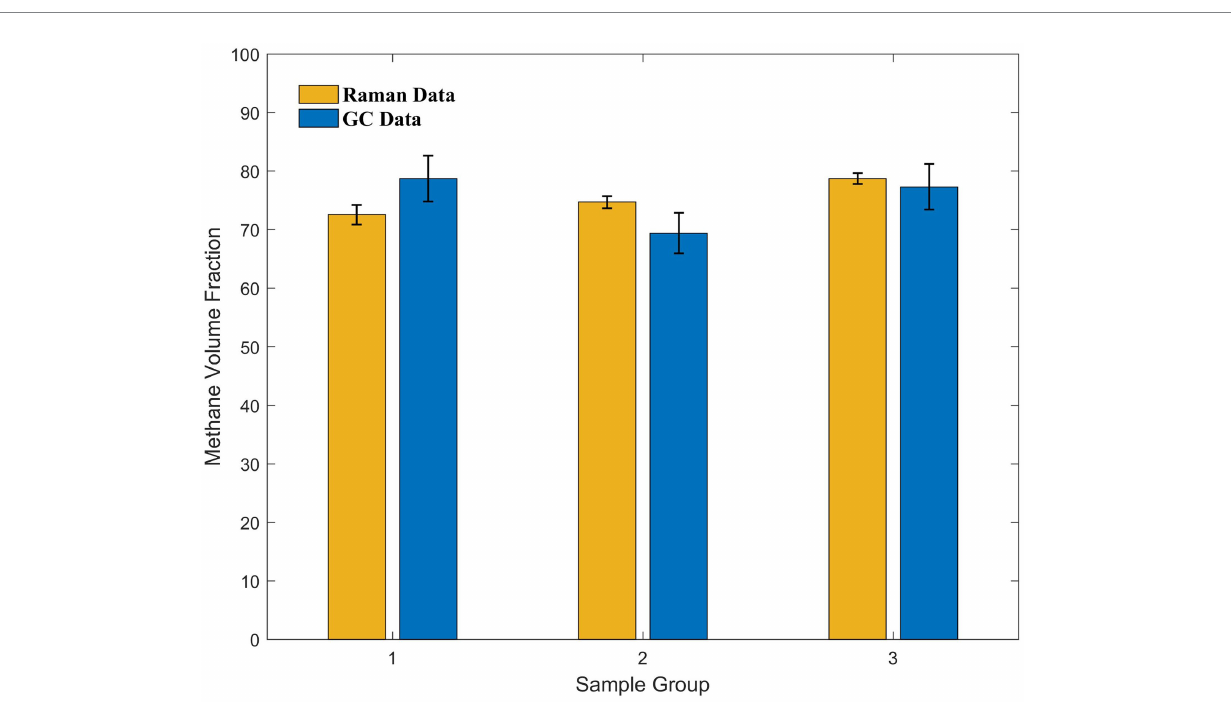
FIGURE 6 Comparison of the Raman and GC data acquired from three sets of samples with different culture times in the later stages of the culture experiments. The methane volume fraction calculated from the curve using Raman data and methane volume fraction measured using GC show good